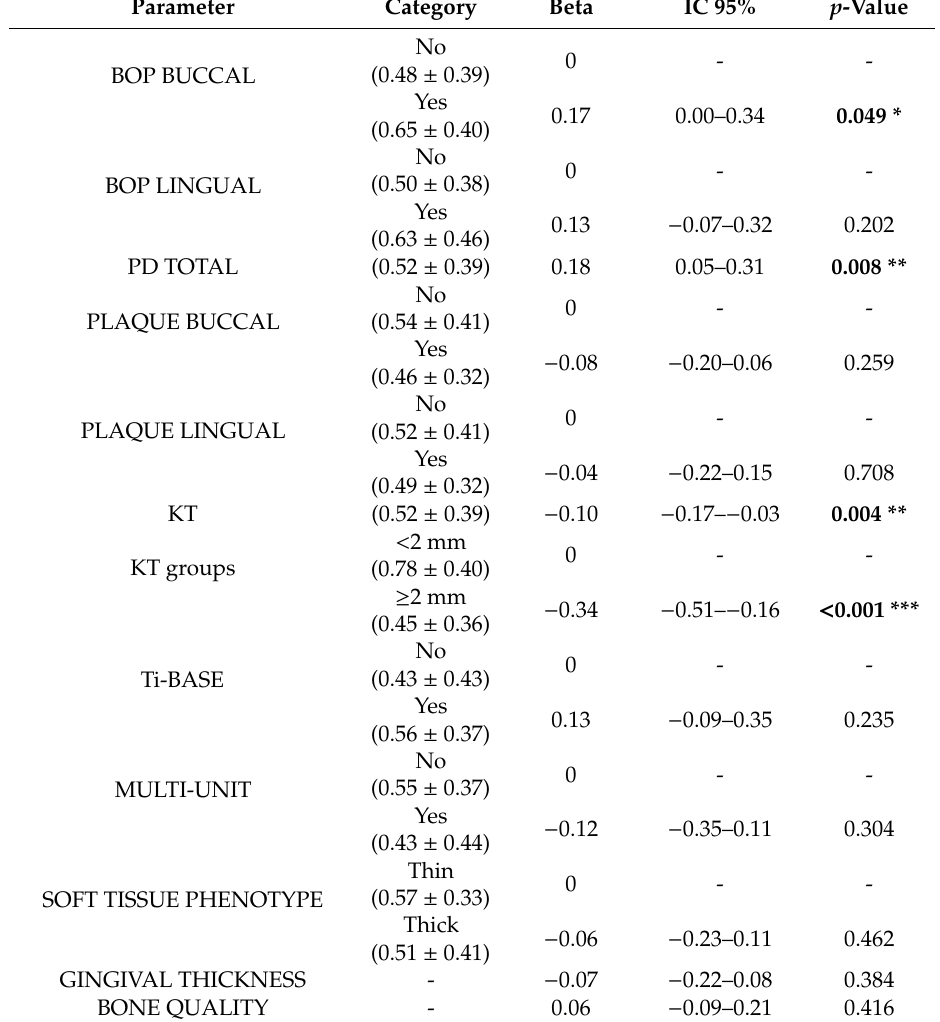
Table 4. Association between MBL and other clinical parameters: Wald chi [2] test results of the general linear regression